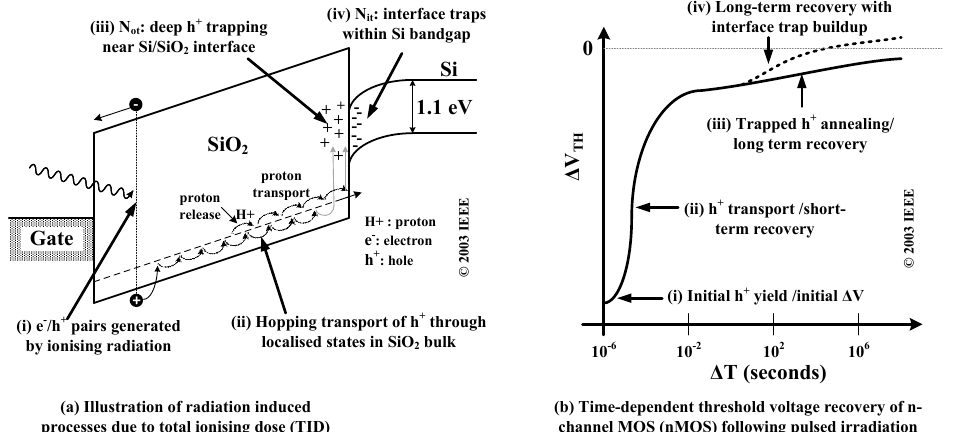
Figure 1. ( a ) Energy band diagram of a positive gate biased metal-oxide-semiconductor field- effect transistor (MOSFET) device showing the effect of ionising radiation on carrier generation, transporting and trapping, and ( b ) the change in threshold voltage of a n-channel MOSFET (nMOS) after radiation strike. Figures are reproduced from [30] with permission of IEEE.